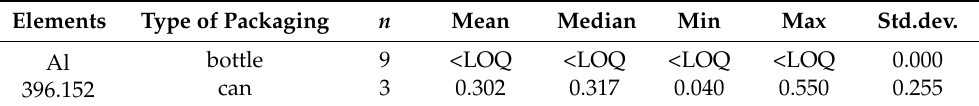
Table 5. Contents of Al (with statistically significant differences) in the measured set of samples ( n = 12; bottles n = 9, cans = 3) in terms of the impact of packaging material, “washout” experiment [mg/L].